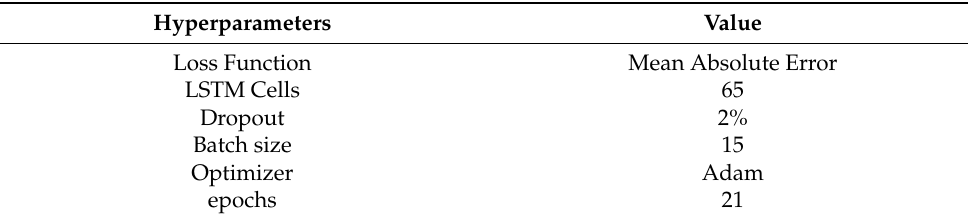
Table 1. Hyperparameters of